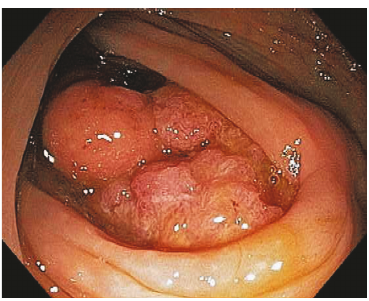
Figure 45: Endoscopic image of a missed cecal cancer after a recent “normal” diagnostic colonoscopy for iron deficiency